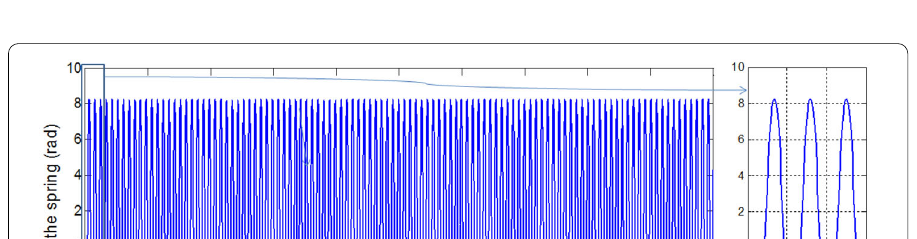
integration method (Eqs. (44) and (48)) where only the increment of ω is of importance. The energy also suffers from the blow-up phenomena as shown Fig.